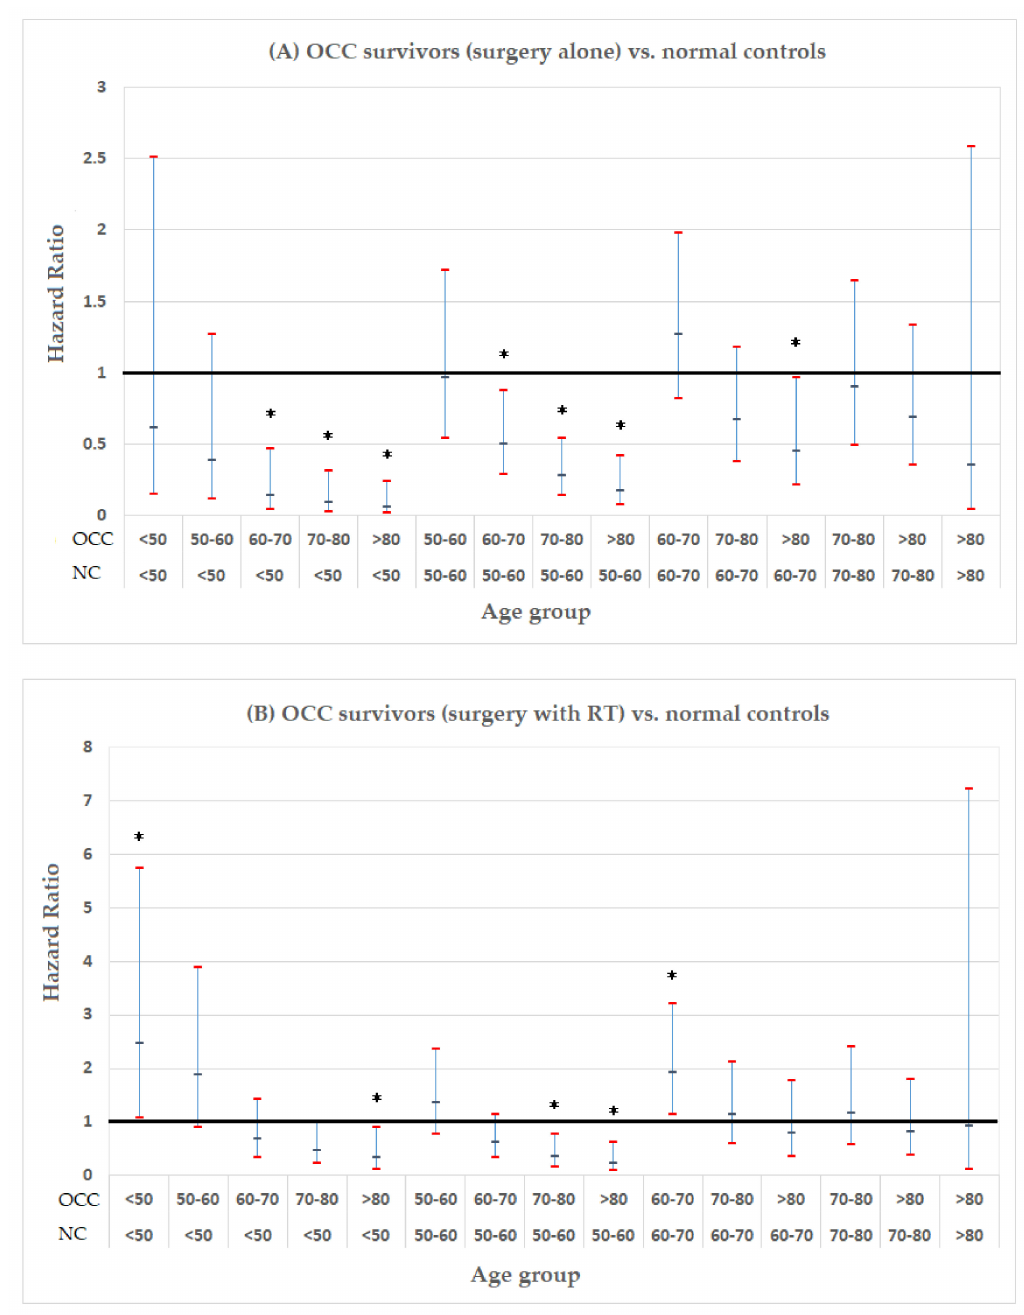
Figure 2. Adjusted hazard ratios with 95% confidence intervals: survivors of oral cavity cancer (OCC) versus normal controls (NC) in di ff erent age groups (* p < 0.05, reference group: normal controls). ( A ) OCC survivors with surgery alone vs. normal controls; ( B ) OCC survivors with surgery and RT vs. normal